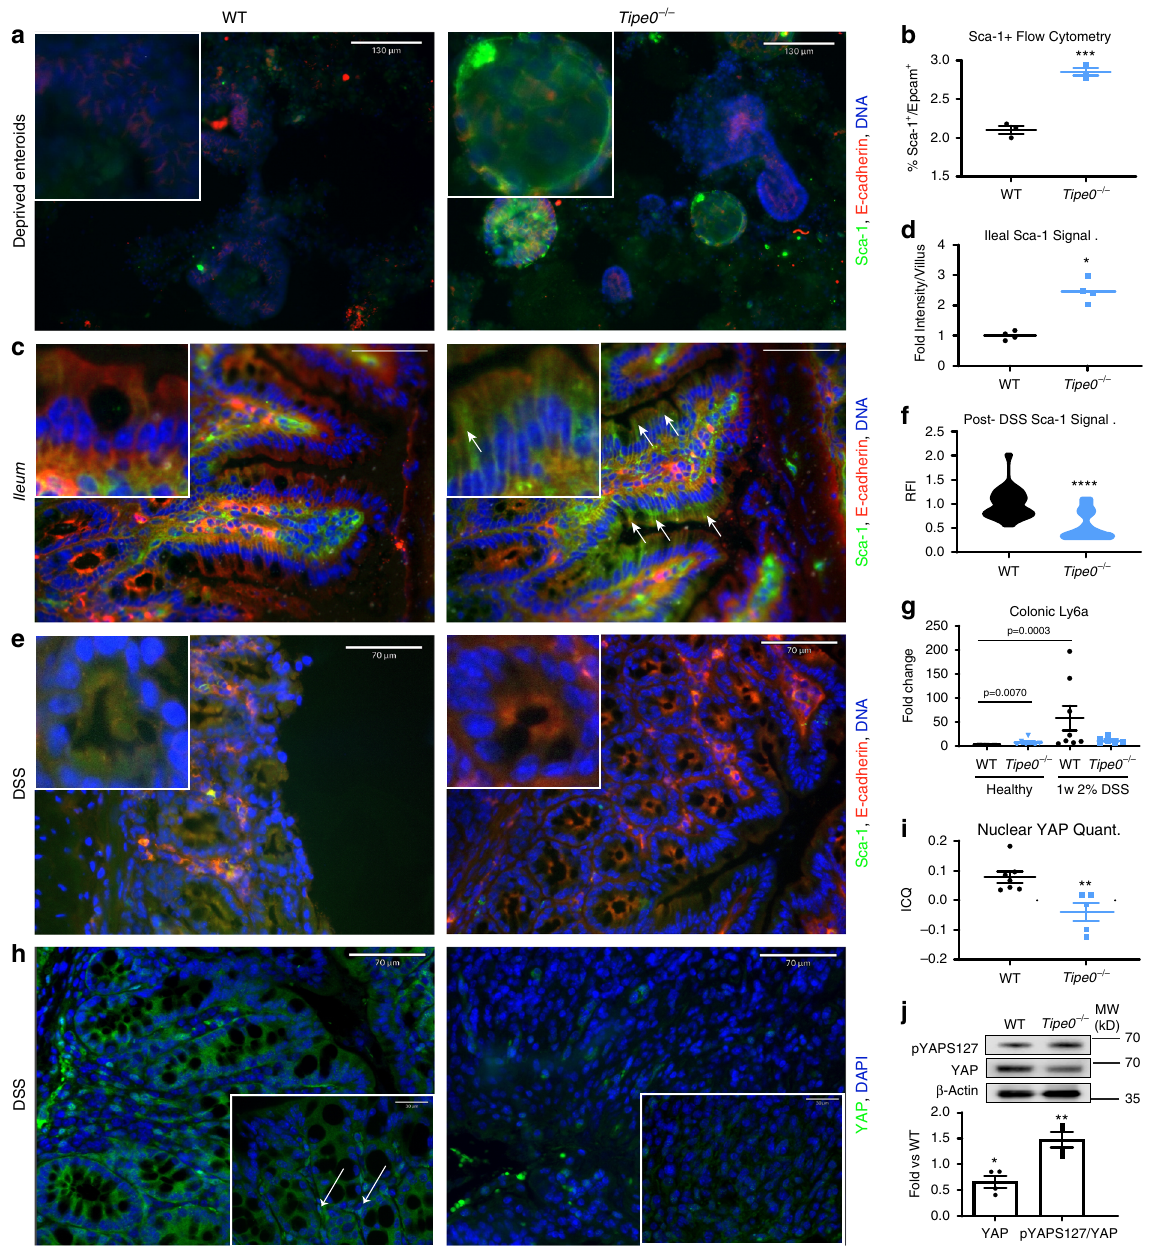
Fig. 6 Tipe0 − / − mice have inappropriate basal activation of the injury-response stem cell program, but an inability to induce the program to regenerate. a Sca-1 staining in Tipe0 − / − spheroids generated by depriving growth factor withdrawal; bars = 130 µ m; insert 3× magni fi ed. Representative of 3 – 4 Tipe0 − / − spheroids/experiment, with three independent replicates. b Flow cytometry for Sca-1 + /Epcam + cells. N = 3, representative of 2 independent experiments. p = 0.0005 two-tailed t -test with Welch ′ s correction vs WT. c IF for Sca-1 and E-cadherin in healthy WT and Tipe0 − / − tissue. E-cadherin was used as an enterocyte counterstain. Images representative of the mean intensity in 4 mice/group, with two fi elds of view/mouse randomly selected; bars = 130 µ m; arrows mark enterocytes staining for Sca-1; insert 3× magni fi ed. Sca-1 staining linearly enhanced in both images for easier merged channel visualization. d Quanti fi cation of enterocyte Sca-1 fl uorescence intensity from c ; N = 4 mice/group; p = 0.0286. e Sca-1 and E-cadherin staining from